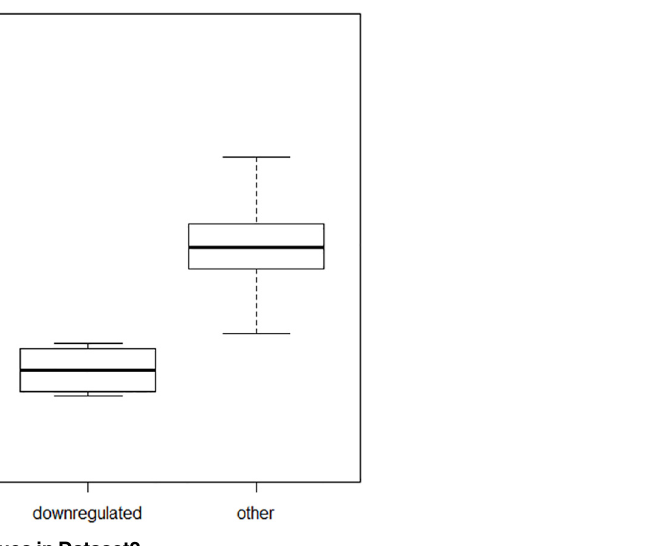
Fig 5. Distribution of values in